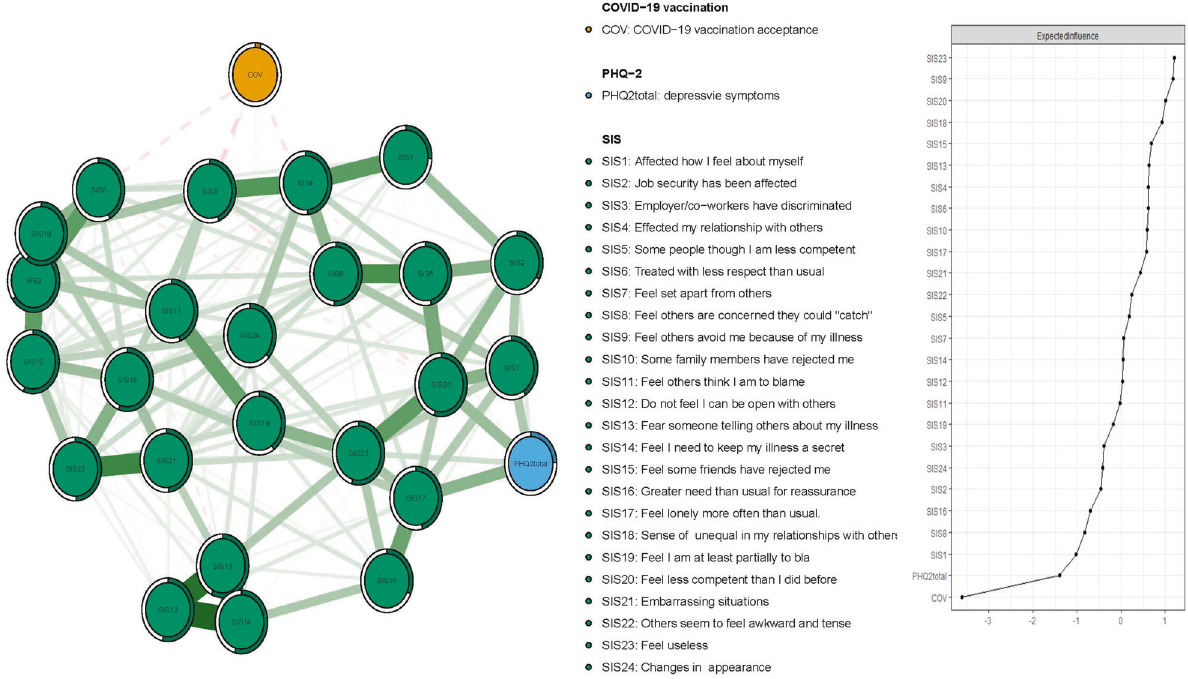
Fig. 2 Network structure of COVID-19 vaccination acceptance and perceived stigma in depressed patients. Ring-shaped pie charts represent predictability (a fully fi lled dark ring would indicate that 100% of the symptom ’ s variance is explained by its inter correlations with the other symptoms in the network). In the diagram symptom nodes with stronger connections are closer to each other. The blue node denotes the PHQ-2 total score items (2-items Patients Health Questionnaire); the red node denotes the SIS items (Social Impact Scale). The dark green lines represent positive correlations. The edge thickness represents the strength of the association between symptom